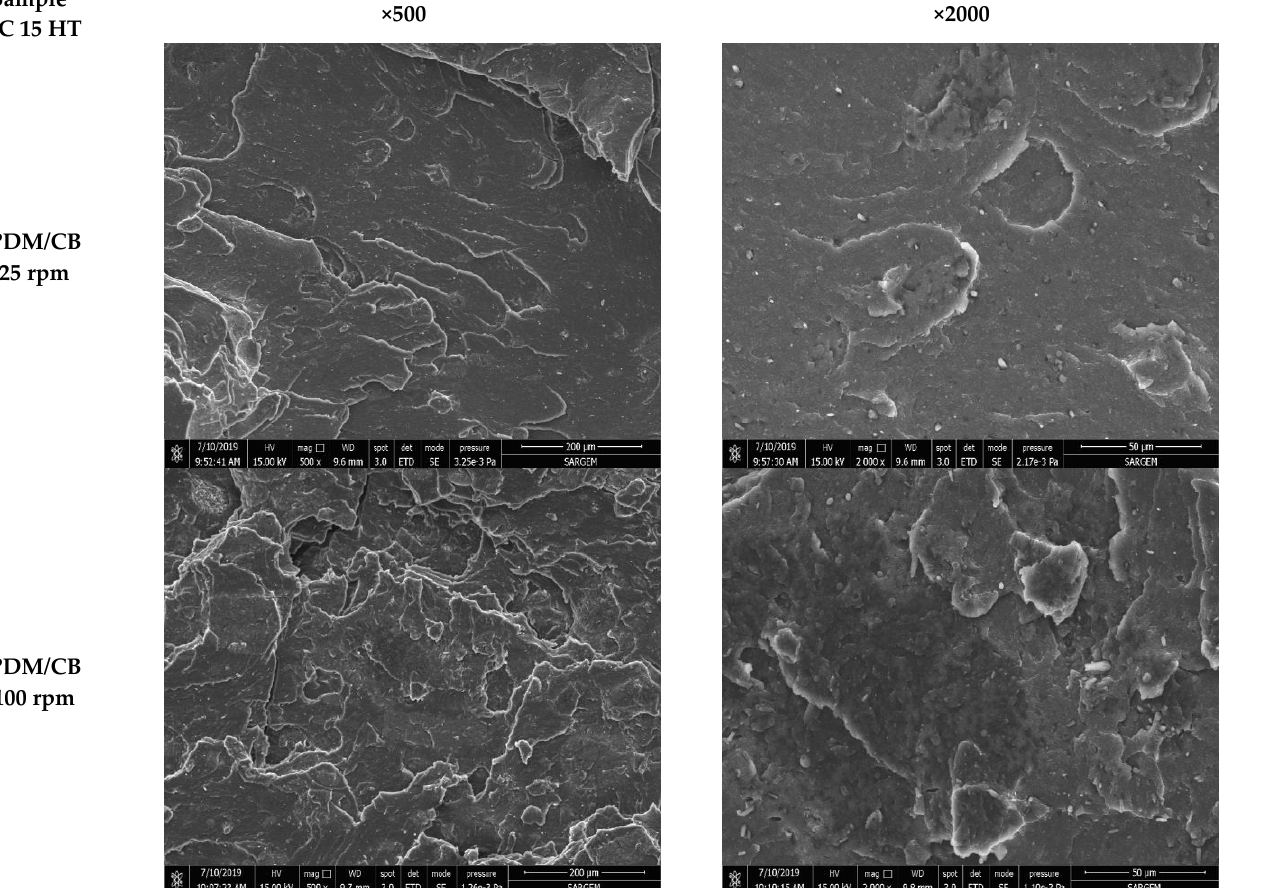
Figure 4. Tensile fractured surface morphologies of the EPDM/CB composites prepared in MC 15 HT (magnification × 500 and × 2000).